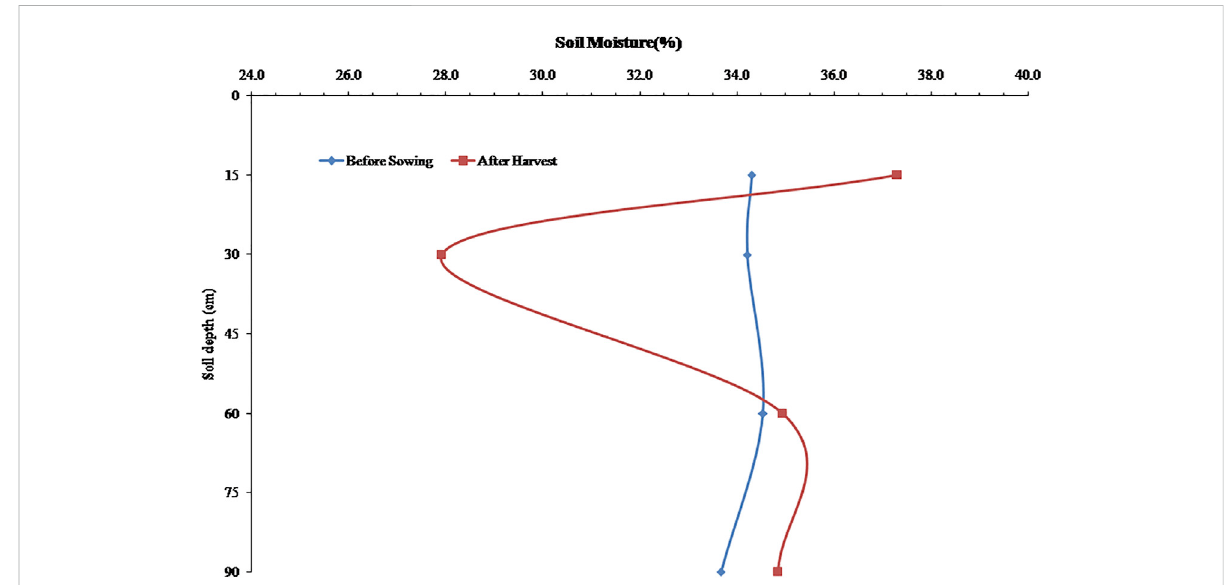
FIGURE 7 Soil moisture (%) in the soil pro fi le before sowing and after the harvest of wheat